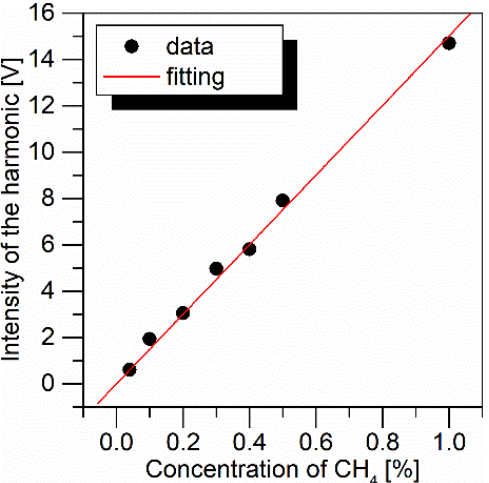
Figure 14. Waveform of second harmonic for 0.2% CH 4 buffered by N 2 .